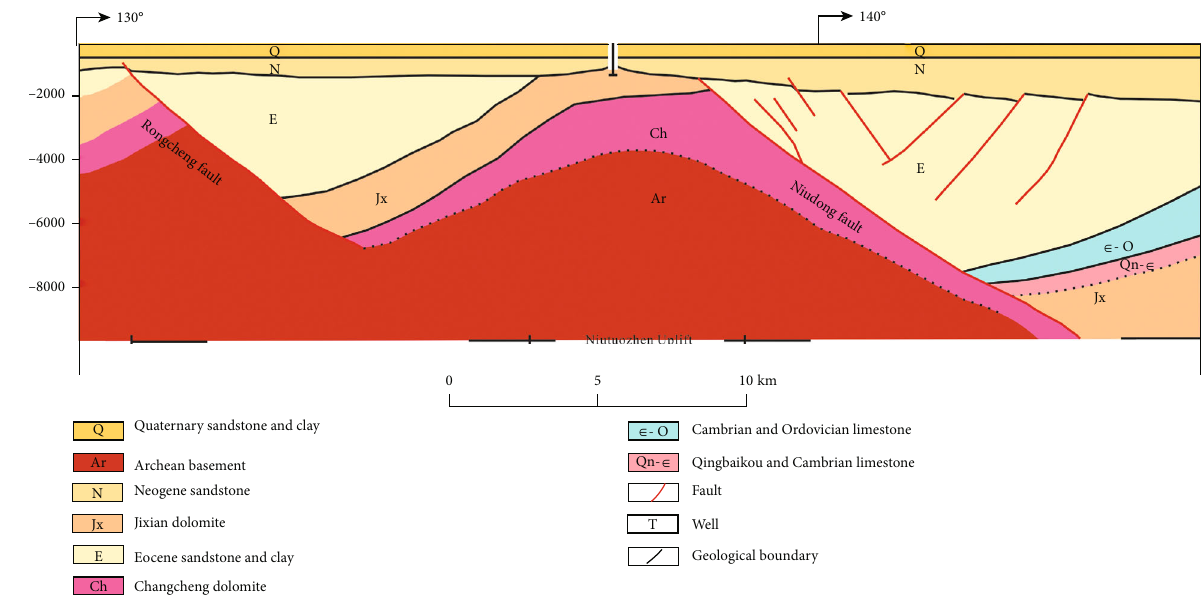
Figure 2: Cross section A – A ′ of the Xiongxian geothermal sector (depth unit: m; revised based on